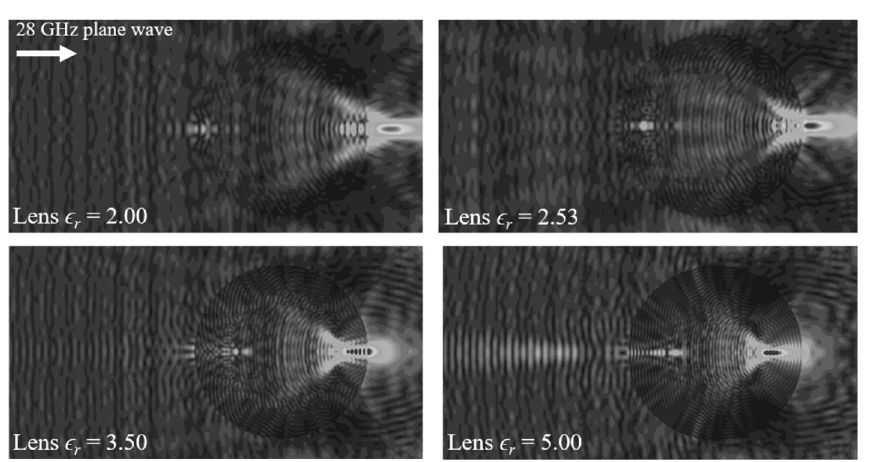
Figure 3. Energy focusing capacity and focal area for the spherical constant- ϵ r lenses with multiple ϵ r